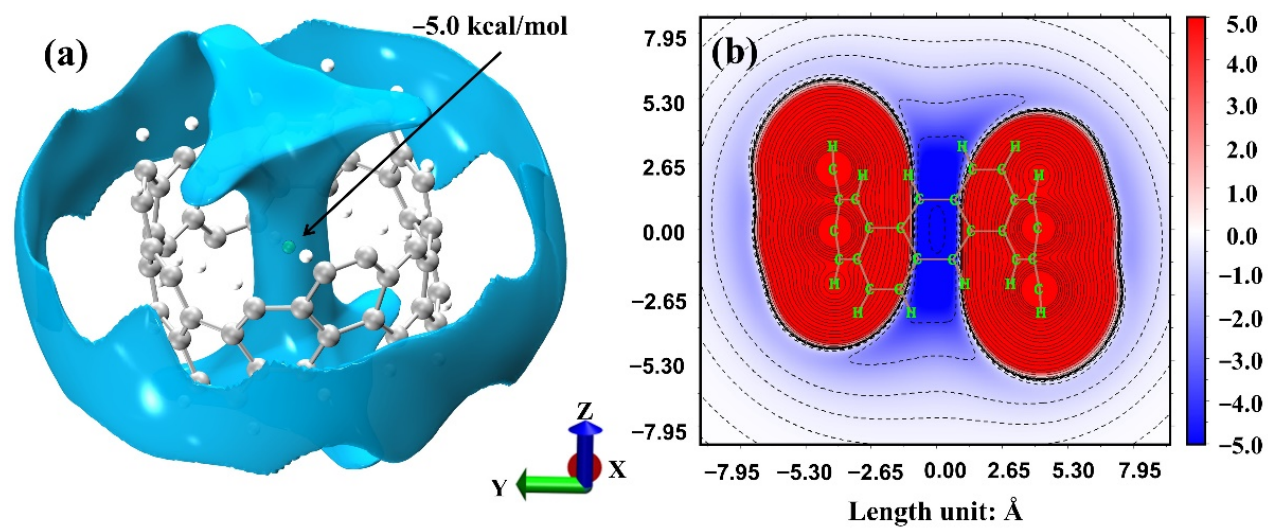
Figure 3. ( a ) The van der Waals potential of [6, 6] CNB (isovalue = − 1.0 kcal/mol); the green ball is the Xe atom probe, and it is at the lowest point of the van der Waals potential. ( b ) Van der Waals potential projection on the yz plane when x = 0, in kcal/mol. In order to study the nature of the adsorption configuration and interaction between [6, 6] CNB and different small molecules (The following is written as [6, 6] CNB&X, [6, 6] CNB& X (ext) and [6, 6] CNB& X (int), X is a small molecule), we optimized a series of configurations for small molecules adsorbed inside and outside [6, 6] CNB (Figures 4 and 5). These small molecules include N 2 , CH 4 , CO, CO 2 , H 2 , H 2 O, H 2 O 2 and O 2